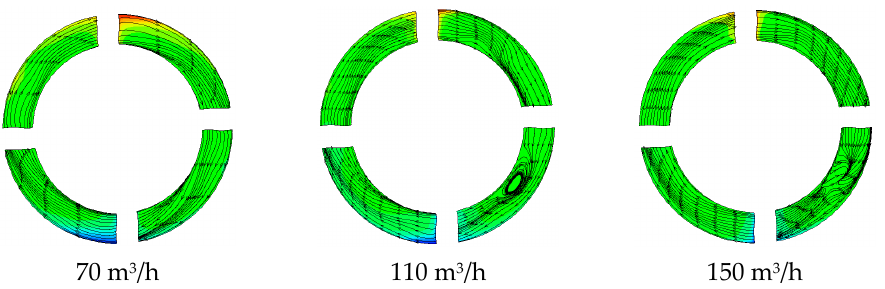
Figure 12. The streamline distribution of the middle section of the inlet section of the first impeller wheel.